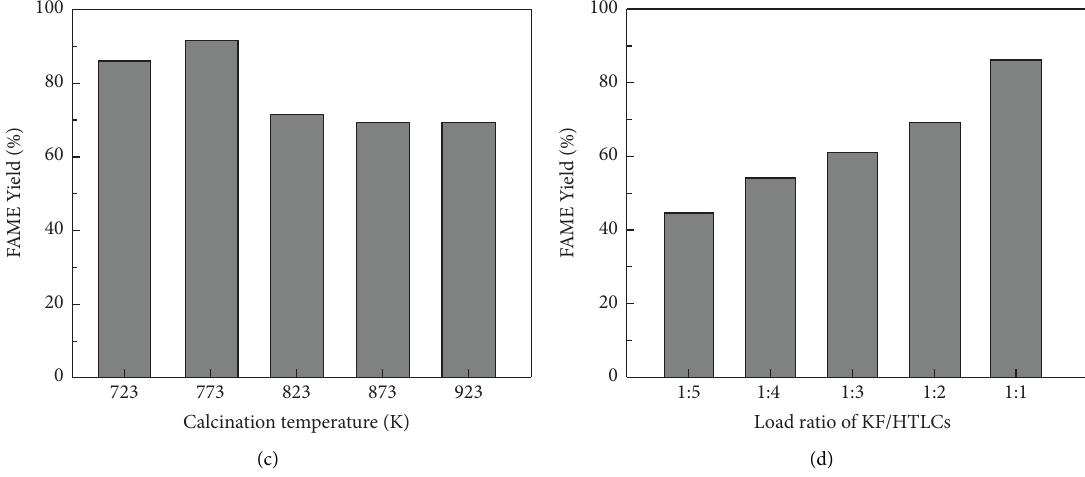
Figure 5: Efect of diferent catalyst preparation conditions on FAME yield: (a) hydrothermal time, (b) molar ratios of Ca/Mg addition, (c) calcination temperature, and (d) diferent load ratios of KF/HTLCs. Reaction conditions: 338K 30min, catalyst (2%), and alcohol/oil molar ratio 12:1.